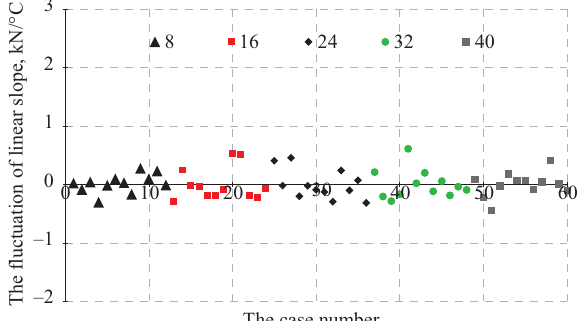
Figure 19. The influence of fracture